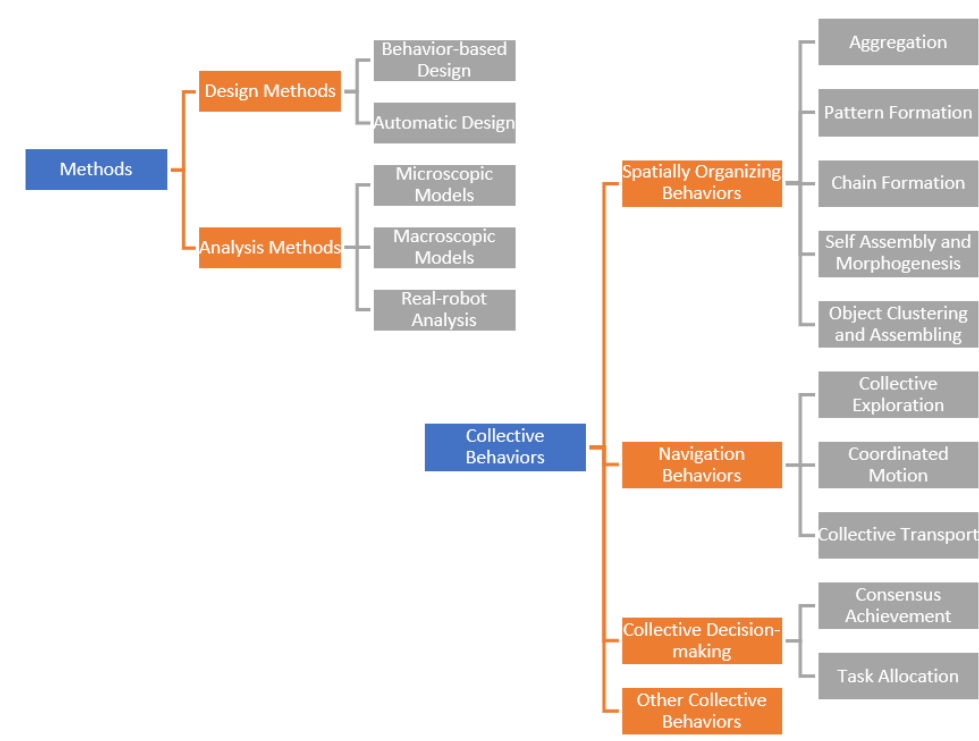
Figure 2. Taxonomy proposed by Bayındır and ¸Sahin [23].